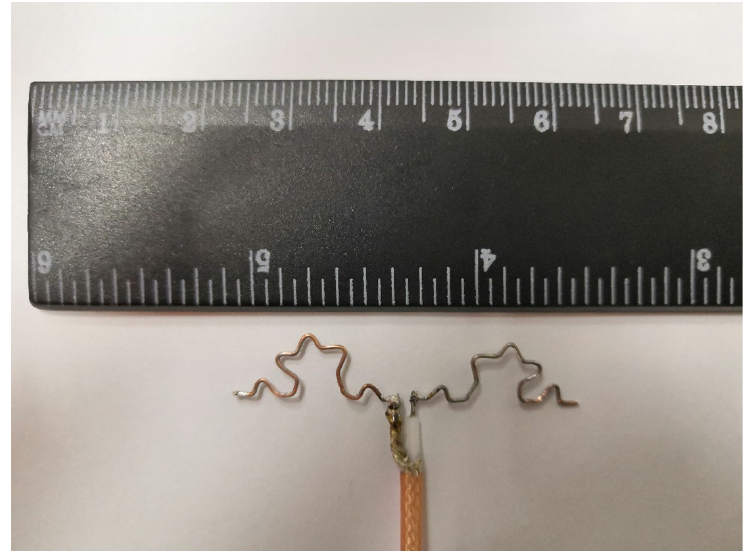
Figure 7. The fabricated antenna with central vertex (0.625, 0.375) for v = 0.02 m.